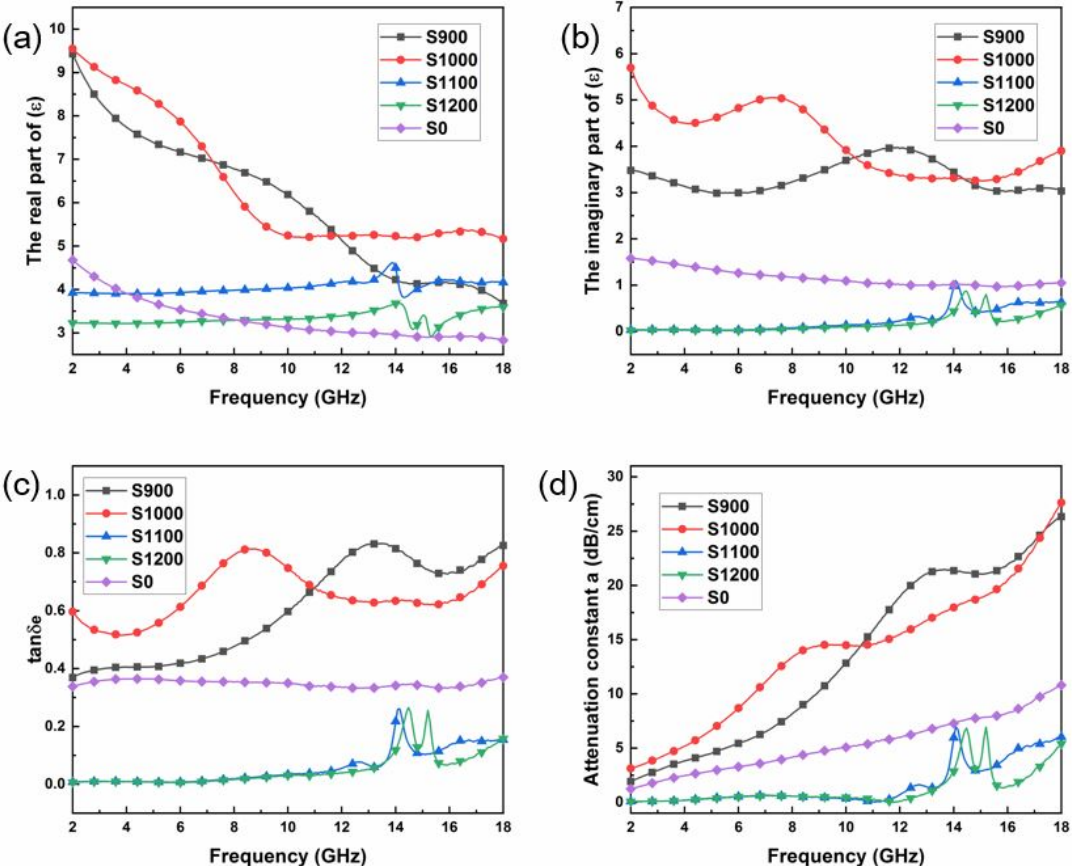
Figure 3. Dielectric loss properties of SiC fibers: ( a ) the real part of relative complex permittivity; ( b ) the imaginary part of relative complex permittivity; ( c ) tangent loss of ( ε ″ / ε ′ ); ( d ) attenuation constant.